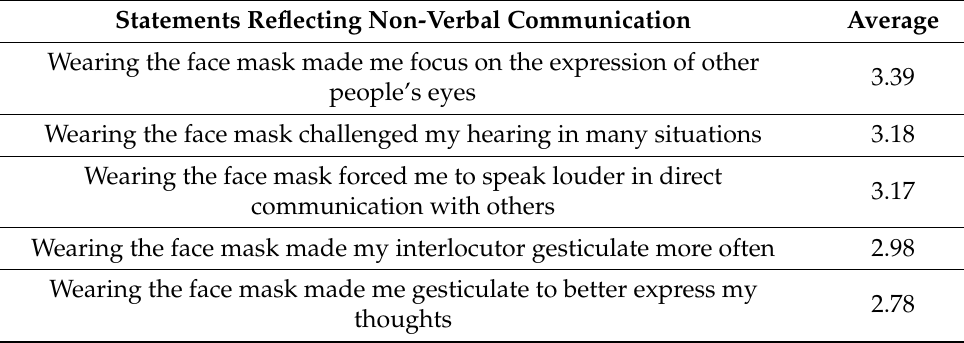
Table 2. Statements reflecting non-verbal communication on a scale from 1 to